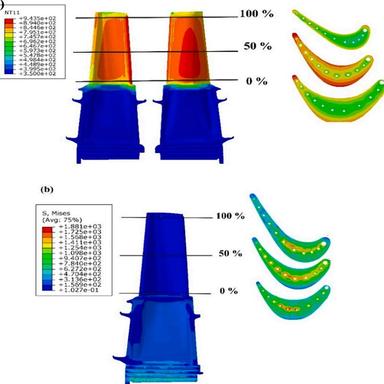
(a) Temperature, (b) stress distribution by FEM results of the blade airfoil.